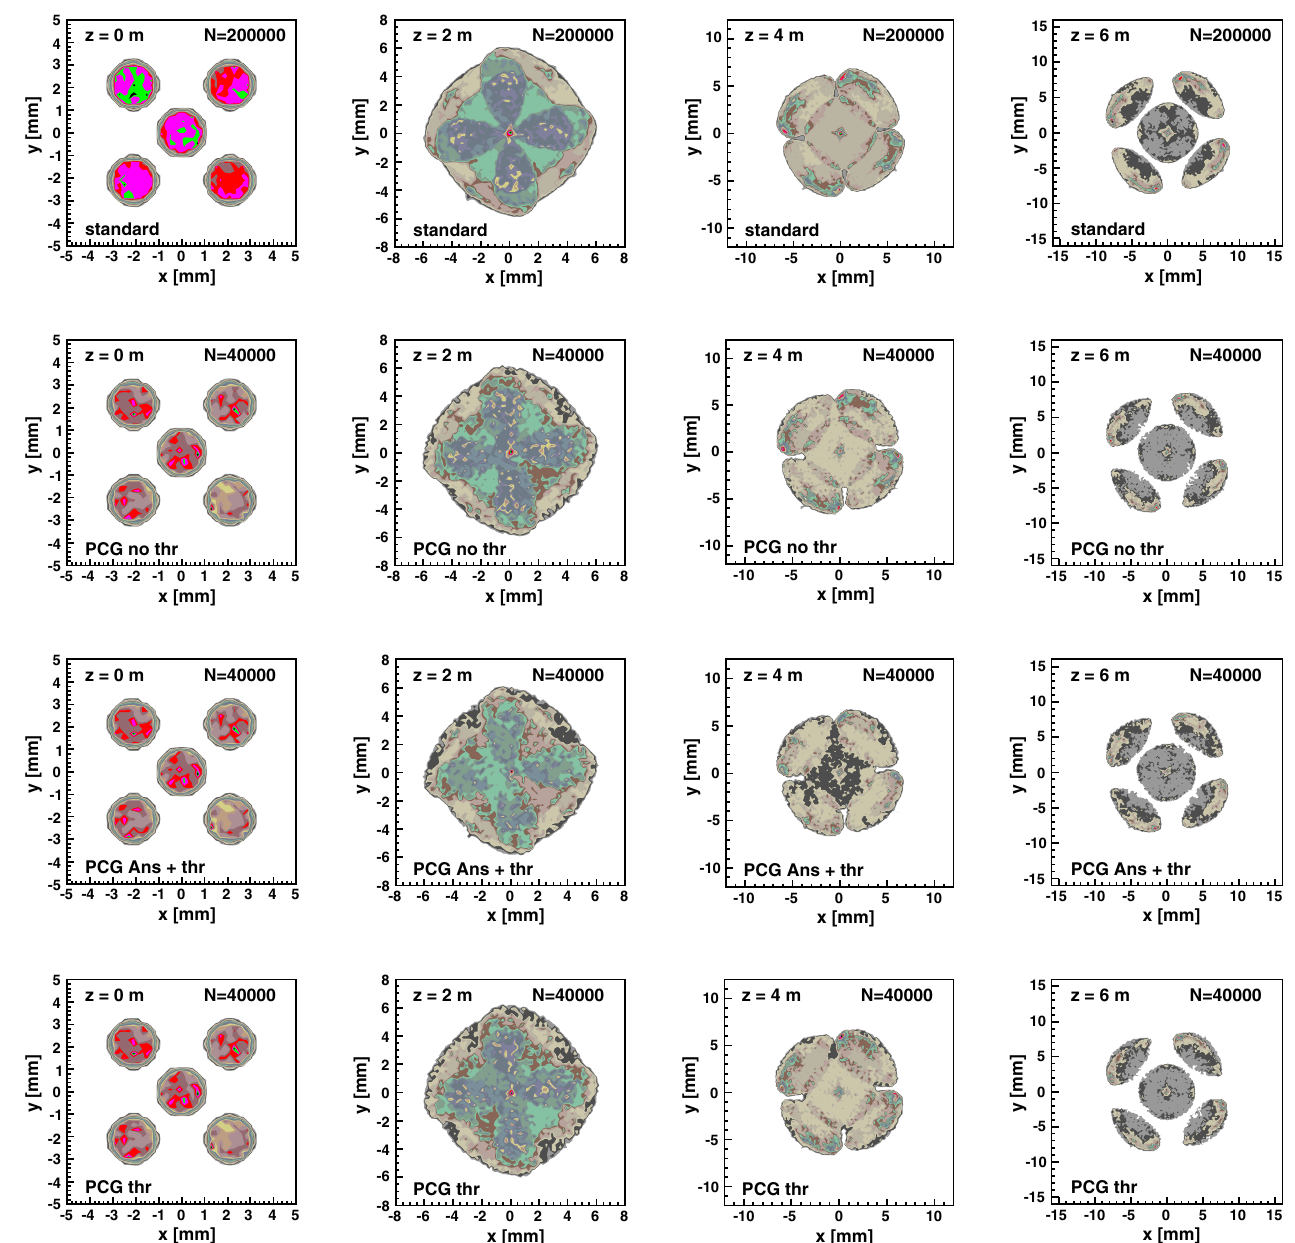
FIG. 16. (Color) Distribution 2 : The same as in Fig. 15, only for Distribution 2 and z (cid:4) 2 m (second column), z (cid:4) 4 m (third column), and z (cid:4) 6 m (fourth